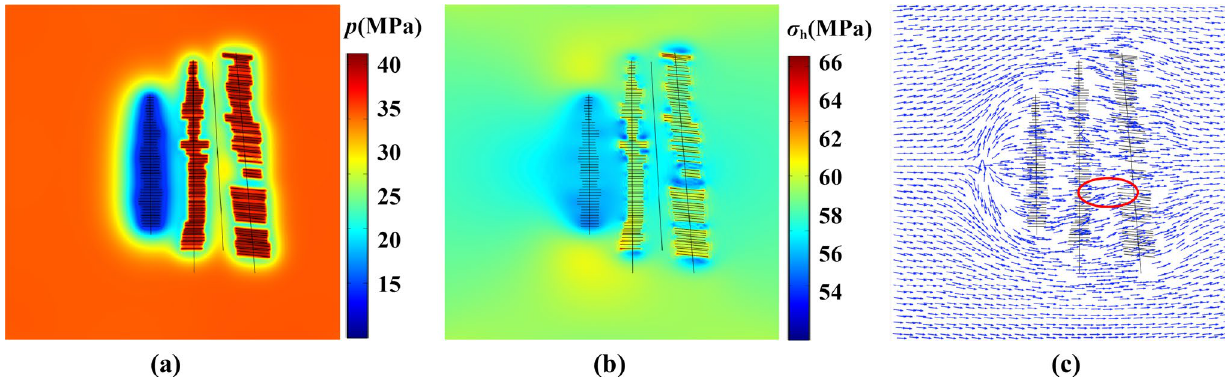
Fig. 9 Pressure and stress field after injection of the two parent wells M-P2 and M-P3 when ξ zontal stress; c orientation of maximum horizontal stress σ H